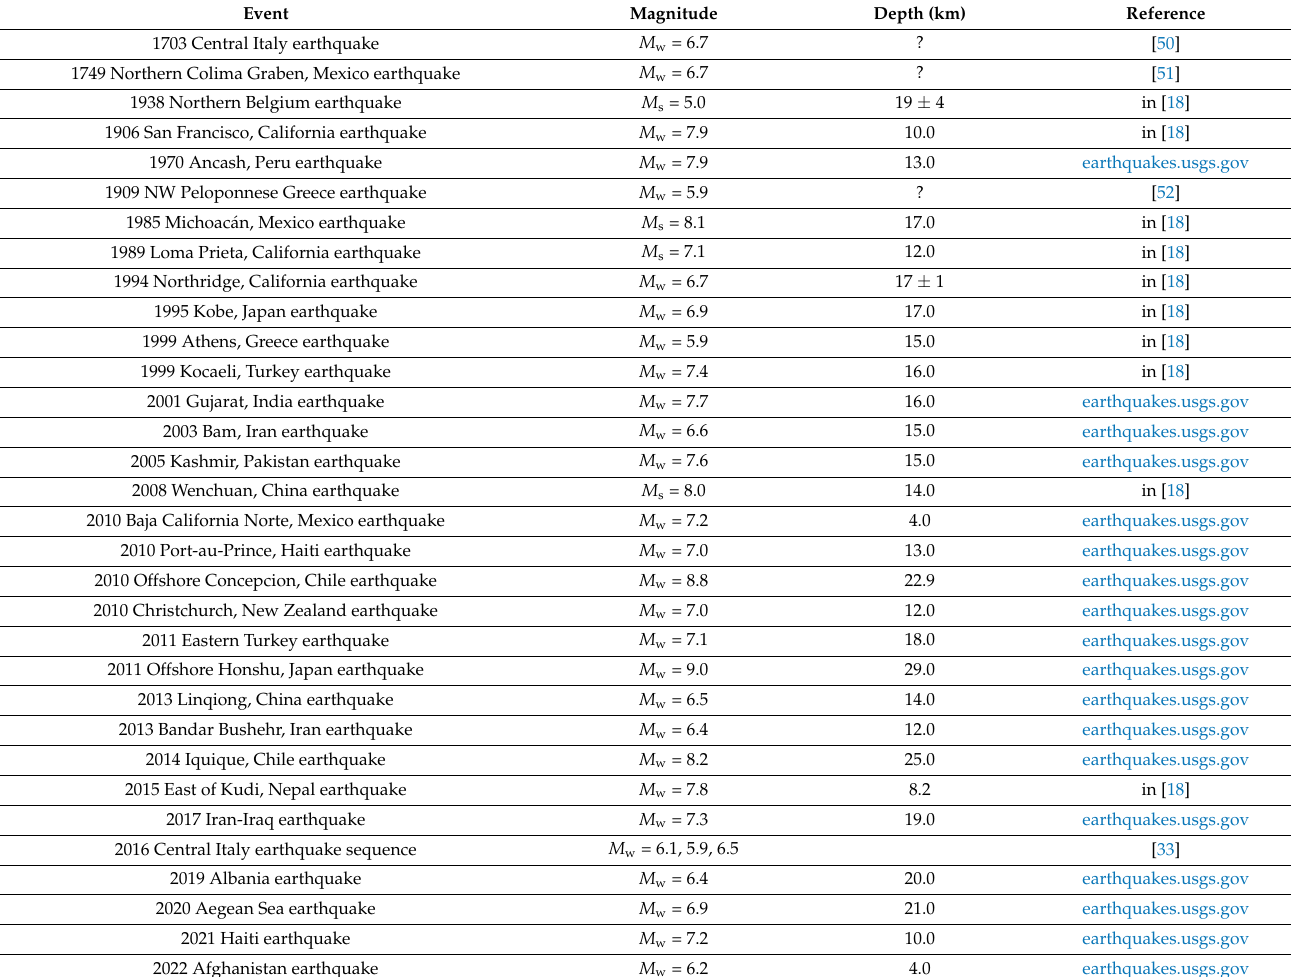
Table 1. Some well-documented damaging earthquakes with observable geological site effects. (Modified with permission from [18]. Copyright 2016, Hinojosa-Prieto,